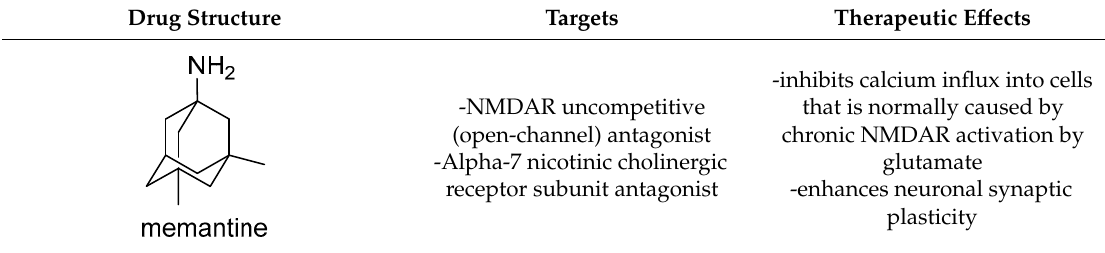
Table 1. Drugs approved for AD therapy.